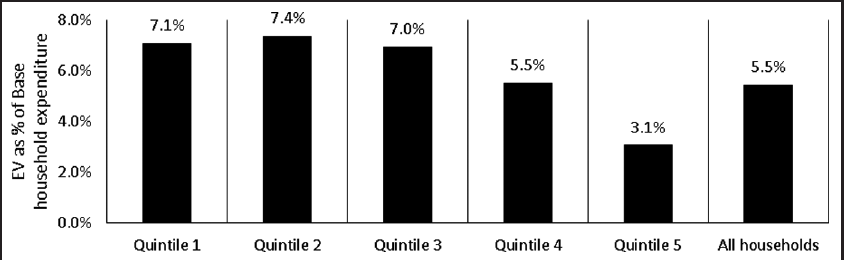
Figure 5 Welfare effects (Equivalent Variation as a share of Base household